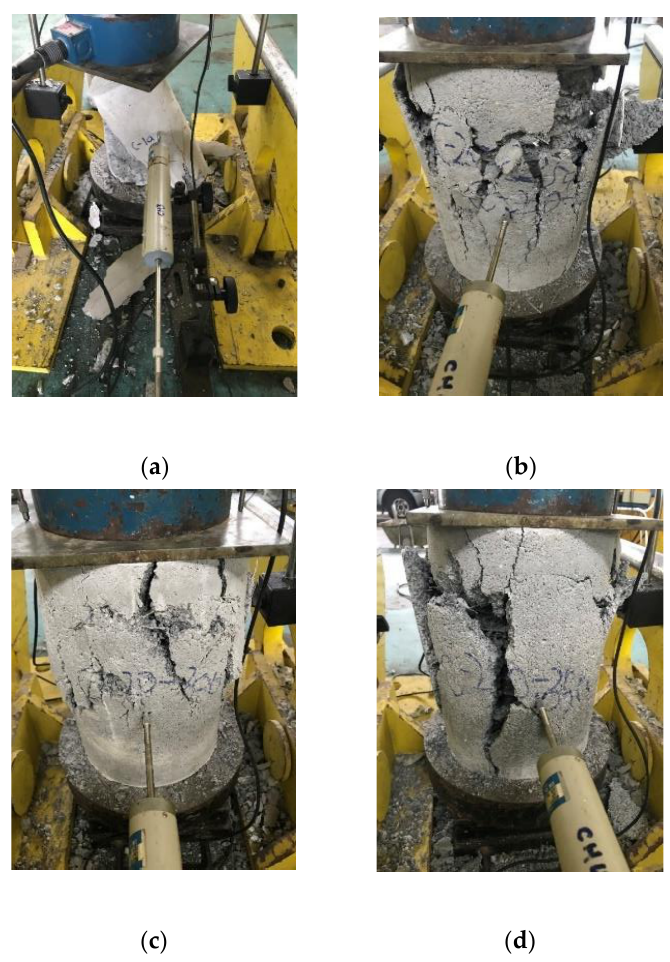
Figure 5. Typical failure mode of tested specimens. ( a ) C-1; ( b ) C-20-25; ( c ) C-20-30; ( d )